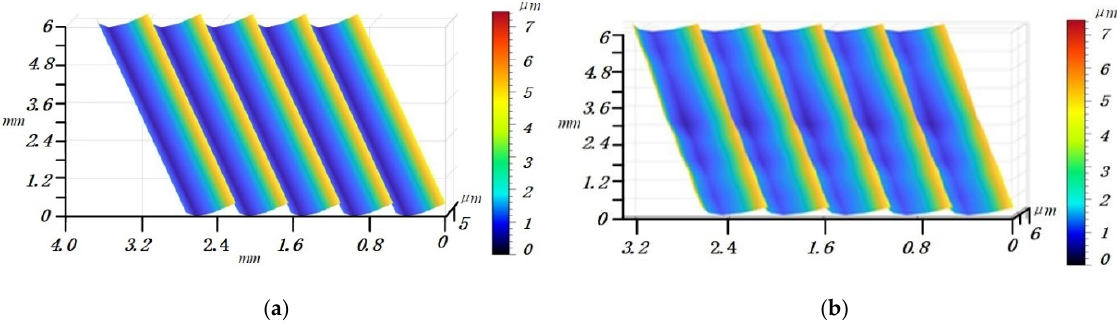
Figure 12. Comparison of simulation results ( a e = 0.4, a p = 6 mm, f = 0.08 mm, S = 1000 rpm). ( a ) The simulation surface topography of the ideal tool path. ( b ) The first set of parameter simulation results.